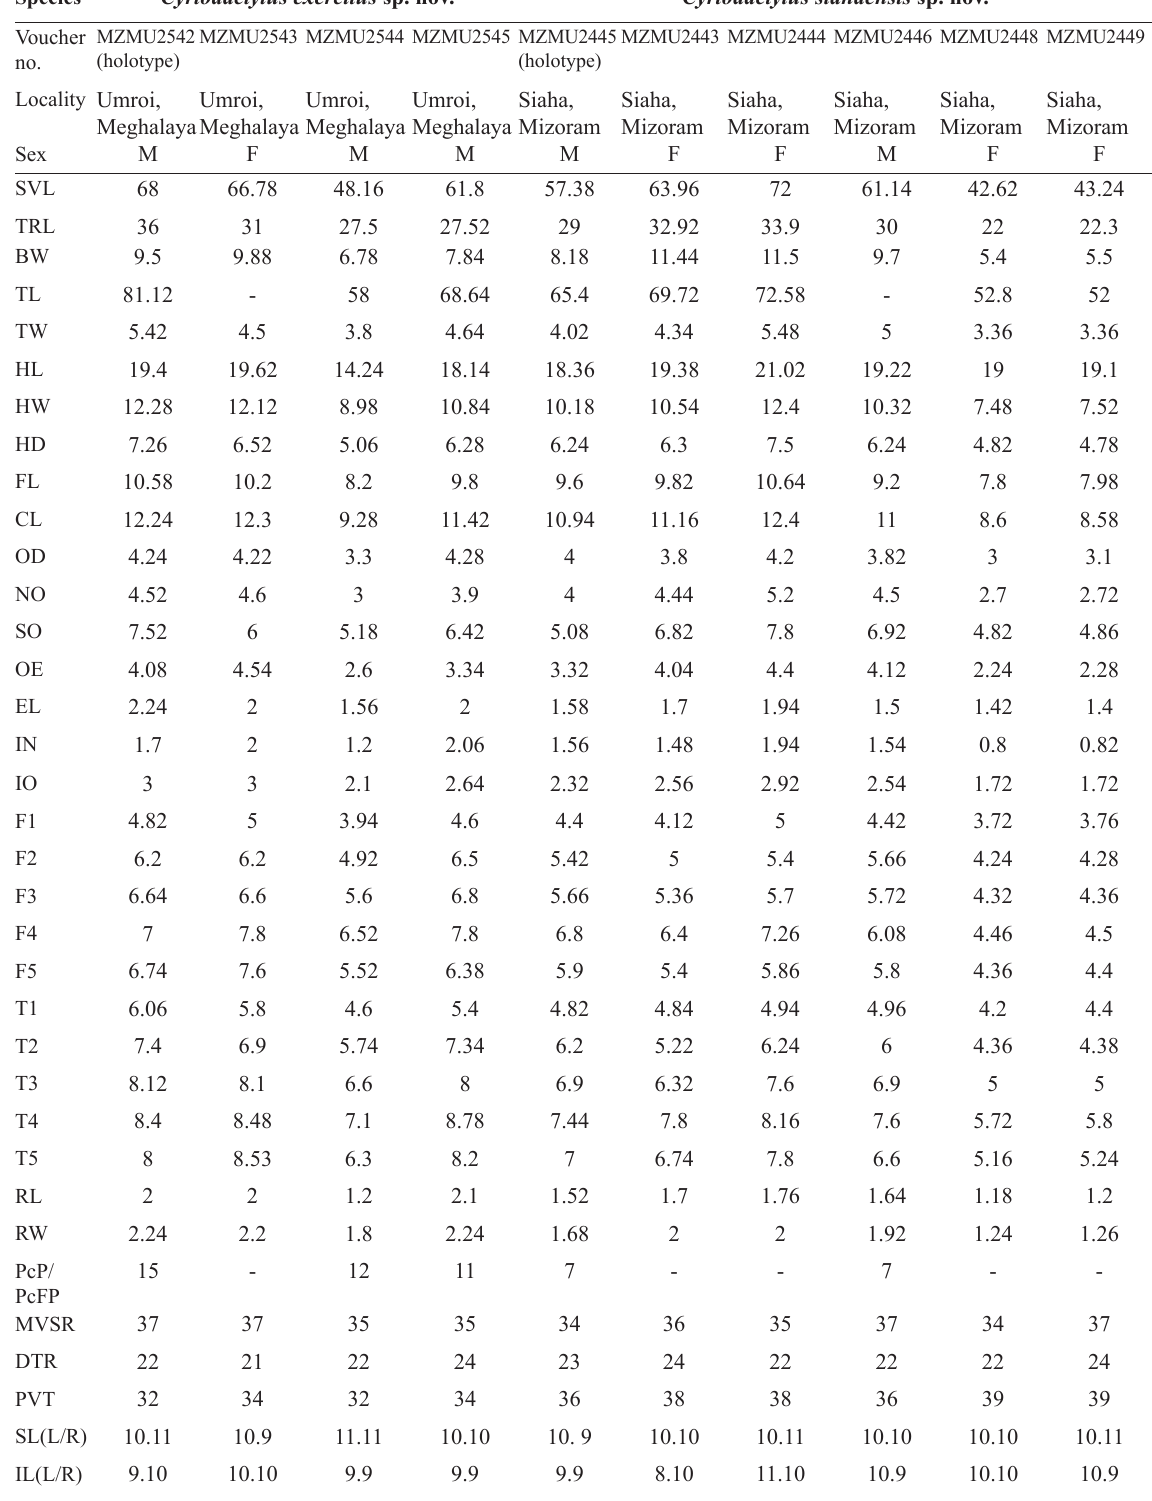
Table 3 . (continued on the next page). Morphometric and meristic data for Cyrtodactylus exercitus sp. nov. and C. siahaensis sp. nov. (all in